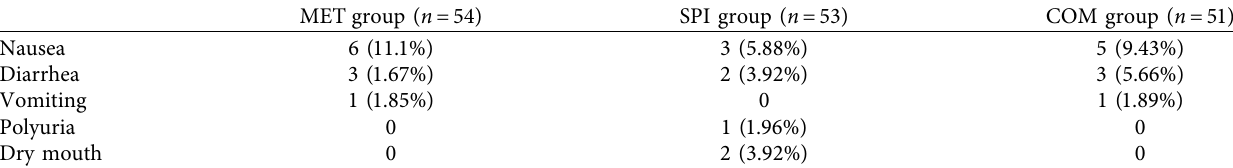
Table 4: Compliance among the three groups during 12 weeks of